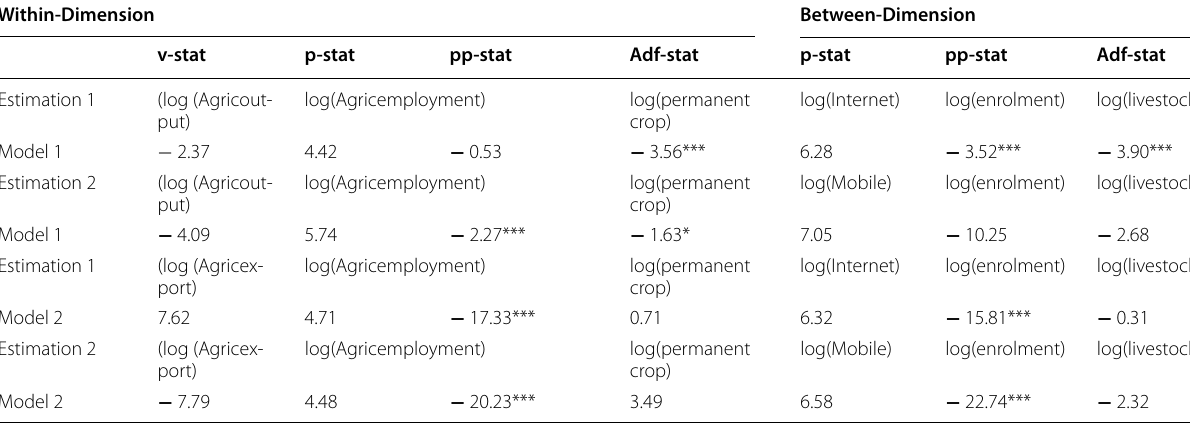
The test statistics are normalized so that the asymptotic distribution is standard normal. *, **, *** indicate rejection of the null hypothesis of non-co-integration at the 10%,5% and 1% significance